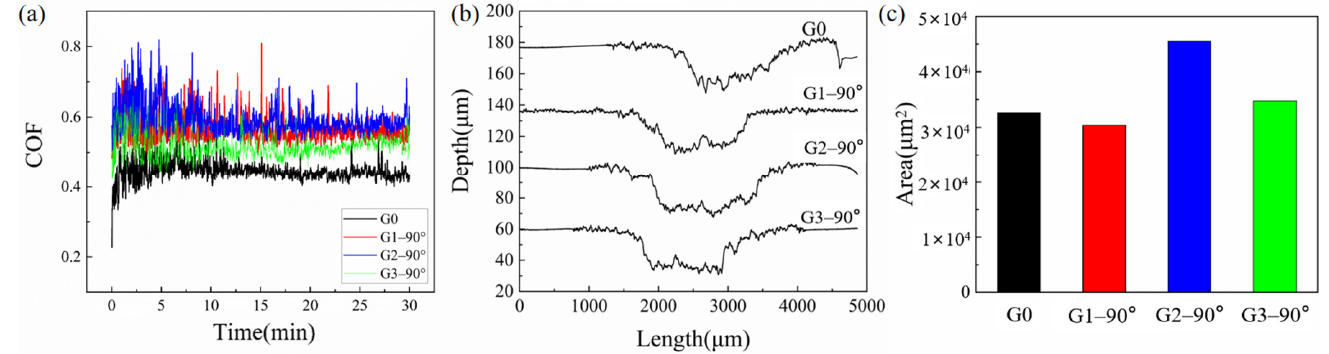
Figure 11. The COF ( a ) and wear section ( b ) and its area ( c ) of YG6X with different texture spacings under the sliding direction of the TC4 ball perpendicular to the groove texture condition.